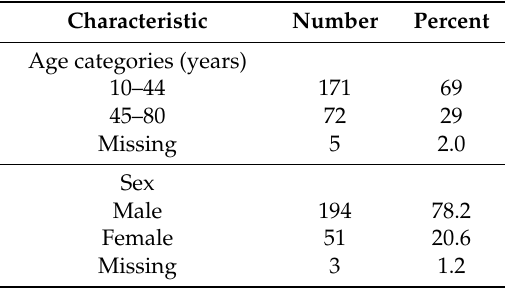
Table 1. Characteristics of human samples collected in the